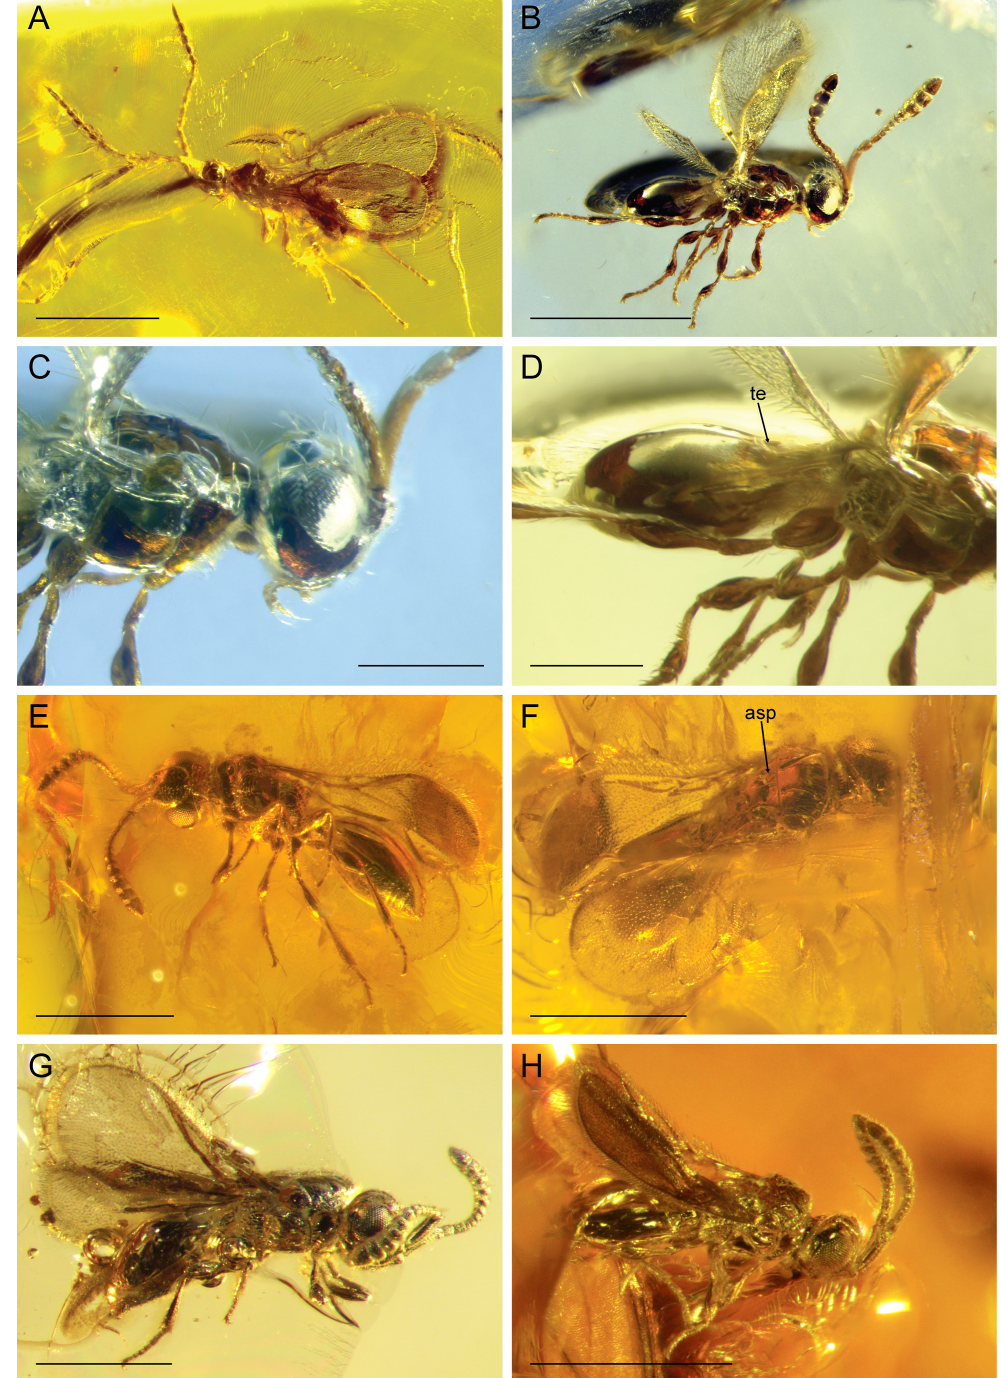
Fig. 6. A . Basalys villumi sp. nov., paratype (NHMD-608369), habitus in lateral view. B–D . Doliopria baltica sp. nov., holotype (NHMD-608374). B . Habitus in lateral view. C . Head in lateral view. D . Mesosoma and metasoma in lateral view. E–H . Spilomicrus succinalis sp. nov. E–F . Holotype (NHMD-607131). E . Habitus in ventrolateral view. F . Head and mesosoma in dorsal view. G . Paratype (NHMD-608344), habitus in lateral view. H . Paratype (NHMD-608354), habitus in lateral view. Abbreviations: asp = anterior scutellar pit; te = tergite excision. Scale bars: A, E–H = 1 mm; B = 0.5 mm; C–D = 0.25